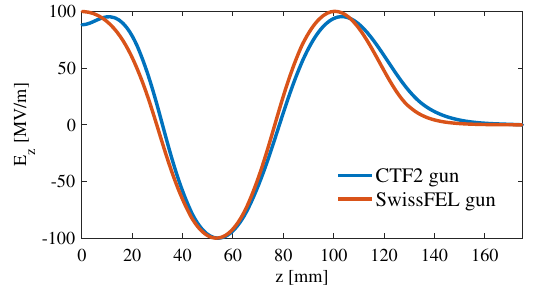
FIG. 3. Normalized on-axis longitudinal electric field profiles for the CTF2 and SwissFEL rf guns.